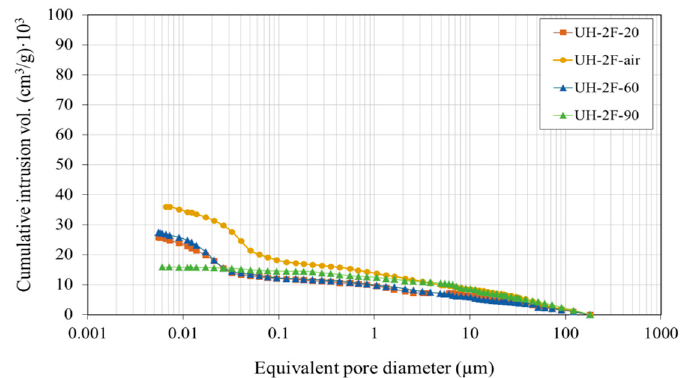
Figure 13. Cumulative pore size distribution.